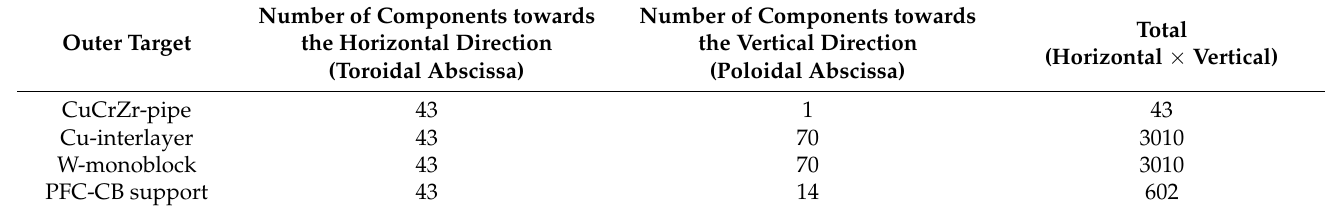
Table 3. Number of PFCs elements towards the horizontal and vertical direction of the outer target (see Figure